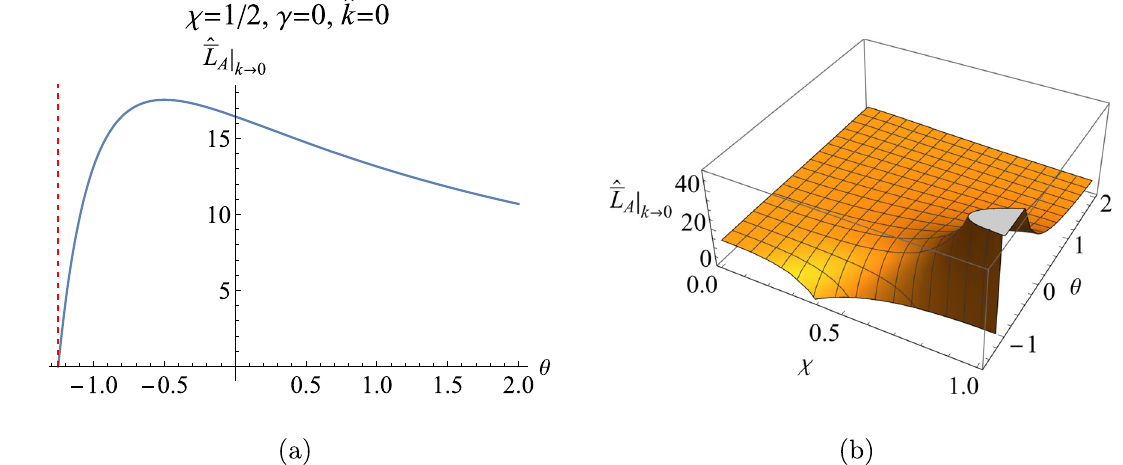
Fig. 9 Left plot: the lower bound as a function of θ for fixed χ . Right plot: 3D plot of the lower bound as a function of χ and θ